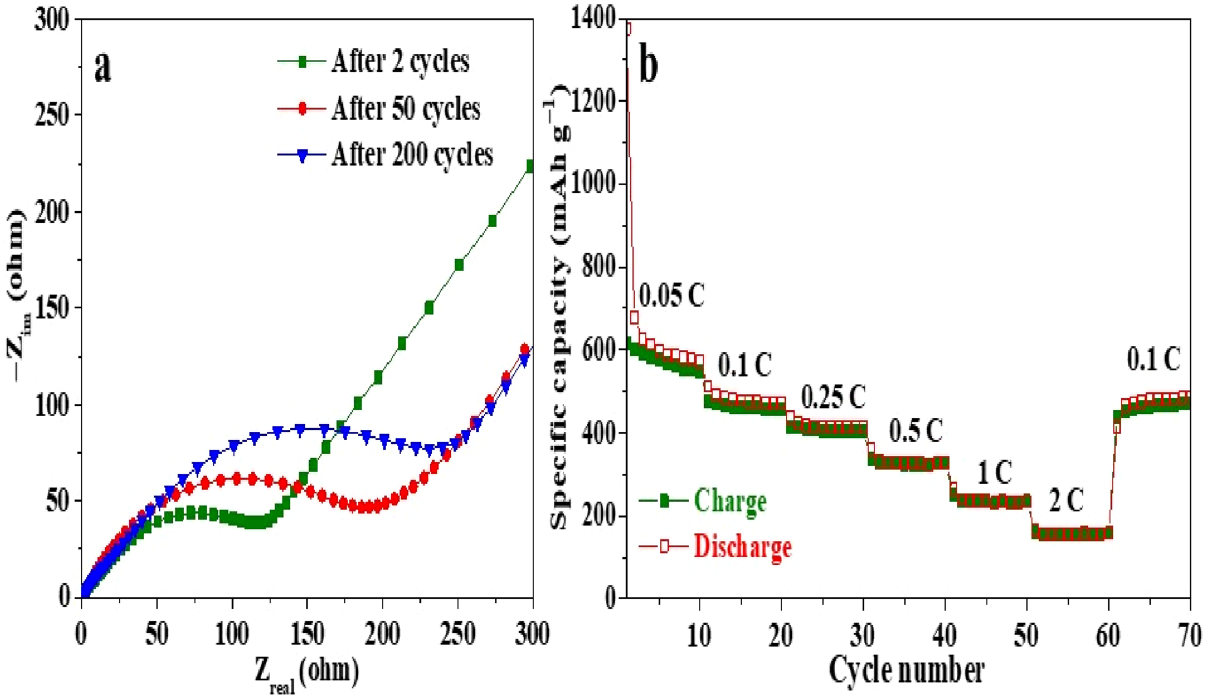
Figure 9. ( a ) EIS data before and after 200 cycles and ( b ) rate capability test.